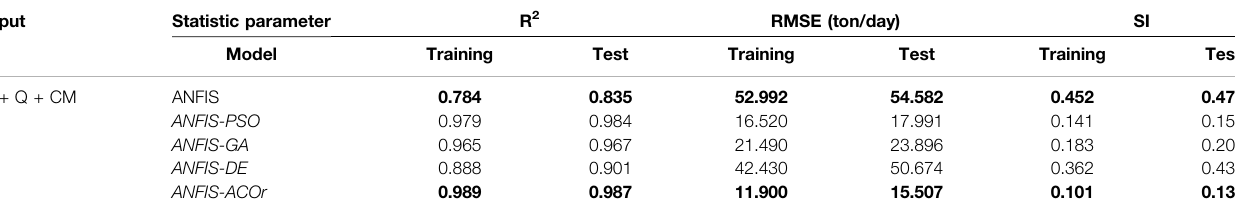
TABLE 4 | Performance of the ANFIS and other hybrid algorithms taking into account all data. Input